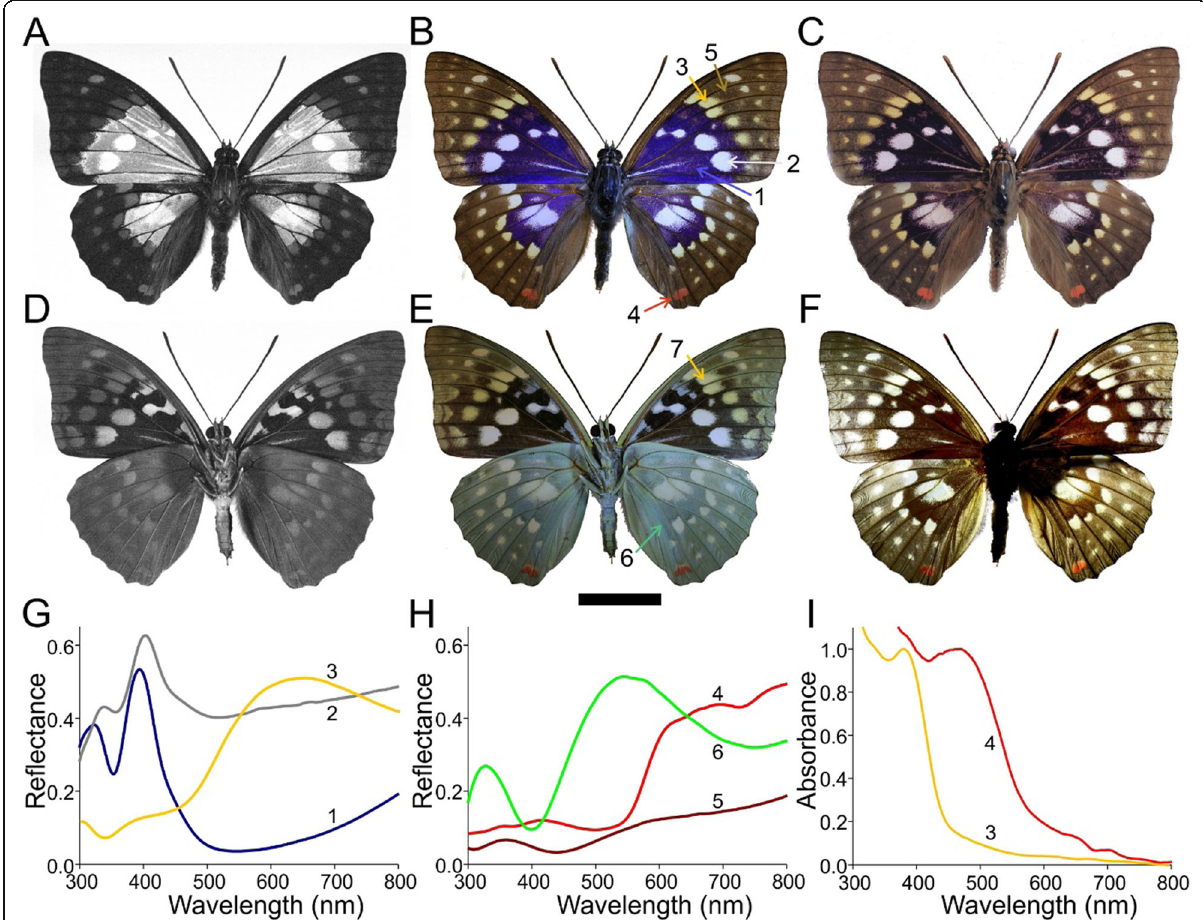
Fig. 1 The great purple emperor butterfly, Sasakia charonda (male). a , b , c , f Dorsal views. d , e Ventral views. a , d UV images. b , c , e , f RGB images. a , b , d , e Normal illumination. c Oblique illumination (angle of incidence of ~ 45°). f Illumination from below, showing transmitted light. Scale bar: 2 cm. g , h Reflectance spectra measured with a bifurcated probe. i Absorbance spectra (normalized at the long-wavelength peak) of pigments extracted from wing pieces cut from an orange-yellow area on the forewing (#3) and from a red spot on the hindwing (#4). The numbers 1 – 6 in g-i correspond to the numbered areas in b and e ; the number 7 in e corresponds to Fig.